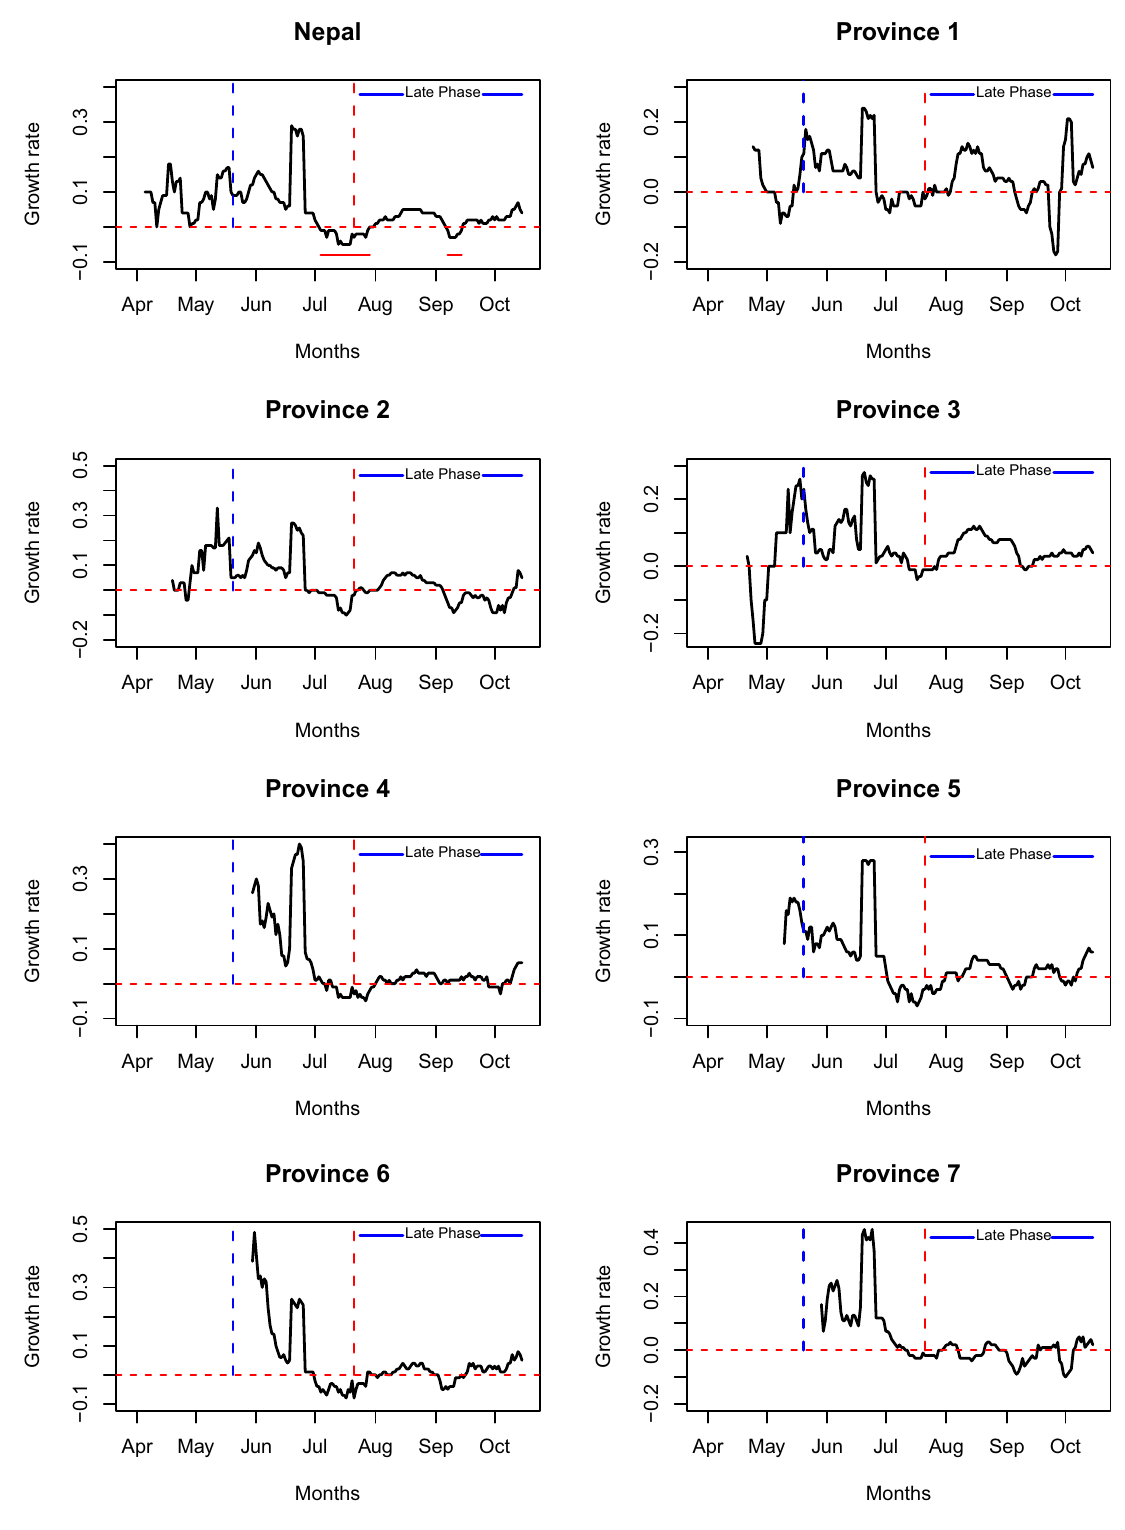
Figure 2. Time-dependent daily exponential growth rate of COVID-19 in Nepal and in its provinces during 2020 pandemics. The vertical blue dotted lines indicate the start date of border opening with screening and the vertical red dotted lines indicate the date at which the countrywide lockdown was ended, after which the epidemic is described as the late phase (solid blue line). The horizontal red line segments in the first graph indicate the time interval at which the countrywide epidemic growth rates are negative. Such line segments are not indicated in the graphs of provinces due to frequently alternating pattern of positive and negative growth rates in individual province. The horizontal red dotted lines indicate the epidemic growth rate of